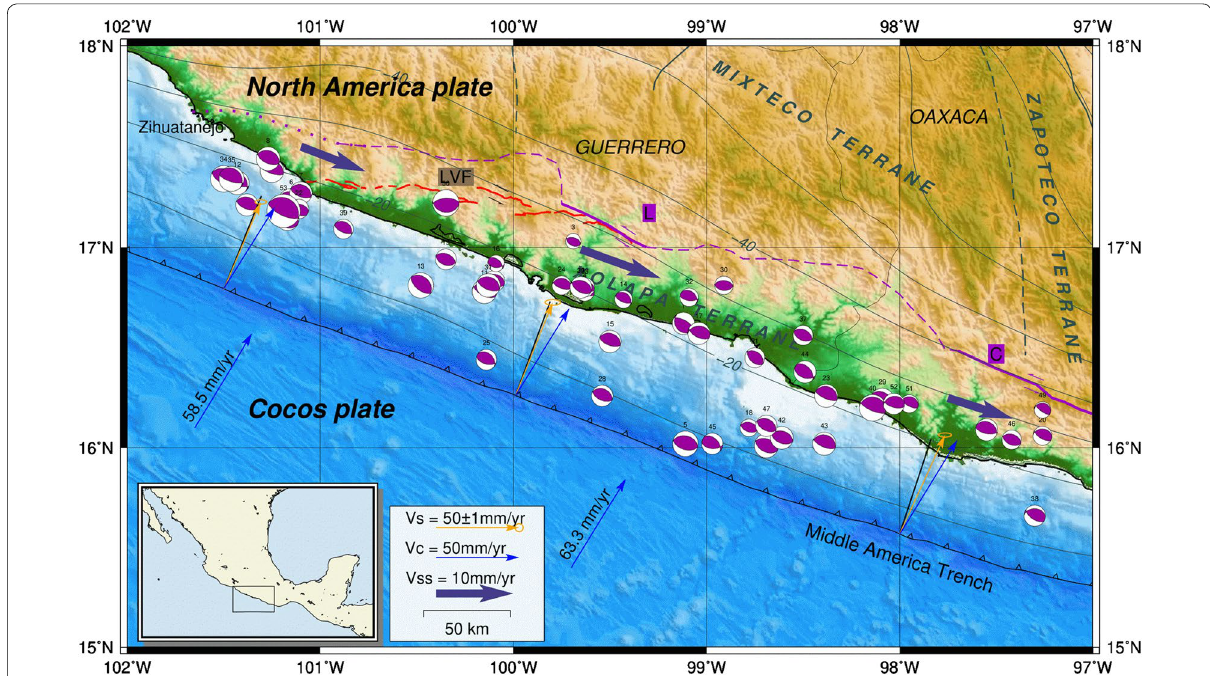
Fig. 1 Earthquakes from the local catalog. Subduction thrust events from Pacheco and Singh (2010) and Yamamoto et al. (2013). Three groups of vectors represent three regions. Black lines indicate normal to the trench, blue arrows—convergence velocity, orange arrows—average coseismic slip vectors projected to the surface for each region with 95% error ellipses. Violet lines are the trace of LVC fault: dashed [from Cerca et al. (2007) and Tolson (2005)], solid [“L”—from Solari et al. (2007) and “C”—from Tolson (2005)]. Red lines are the location of the La Venta fault system from the geomorphology study of Gaidzik et al. (2016). Terrane subdivision according to Campa and Coney (1983), Sedlock et al. (1993), and Keppie (2004). Darkblue arrows show the Xolapa sliver motion. Solid and dashed gray lines indicate regional faults [from Solari et al. (2007)]. Thin gray lines are the plate interface isodepth contours (Hayes